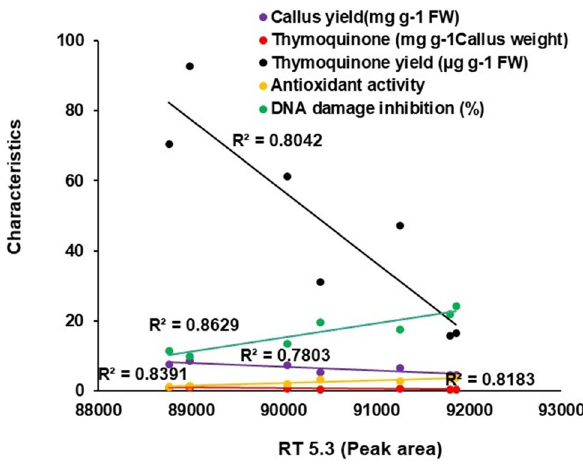
Figure 10. Peak area at 5.3 min retention time correlates negatively with callus yield ( p < 0.05), thymoquinone yield and content ( p < 0.01) and positively with antioxidant activity ( p < 0.01) and DNA damage inhibition ( p <